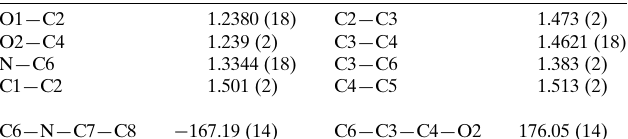
Table 1 Selected geometric parameters (A˚ , (cid:3) ) for 1 .